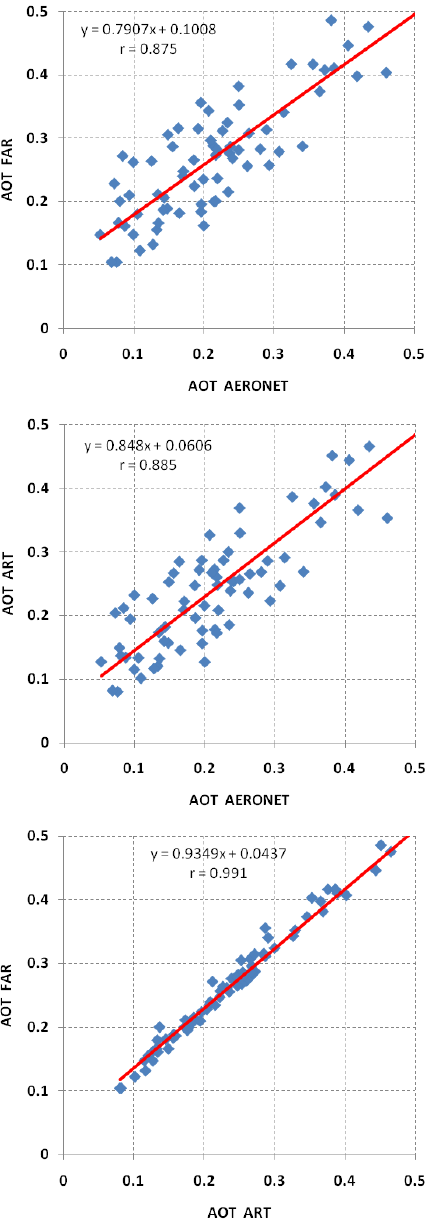
Fig. 16. AOT retrieval at 440nm with codes FAR (top) and ART (center) in comparison with the measurements of AERONET sta- tions in Zvenigorod (Russia, near Moscow) and Belsk (Poland) for periods from March to September in 2008 and 2009 and correlation of values of AOT retrieved with ART and FAR technique